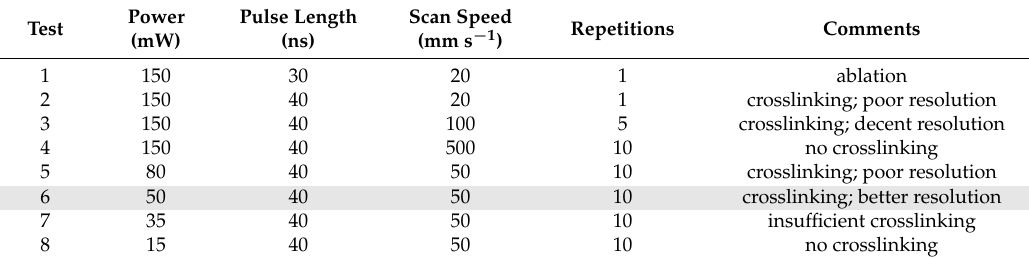
Figure 7. Experiments with ns-pulsed 355 nm laser: ( a ) during laser scanning with 150 mW; ( b ) resultant crosslinked polymer with black ablated pattern; ( c ) photo-crosslinked green body (using 50 mW power) without ablation. Table 4. Processing conditions tested with laser system 2: 355 nm ns-pulsed laser. Entry 6 is highlighted to indicate the best